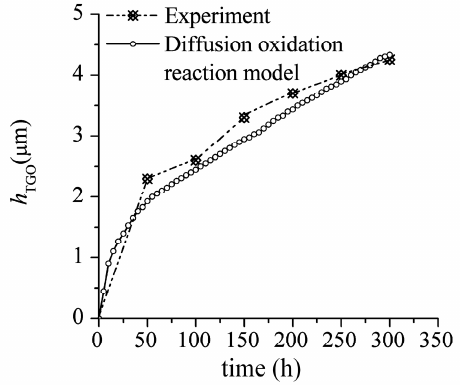
Figure 4. Evolution of TGO thickness using the proposed diffusion oxidation model.